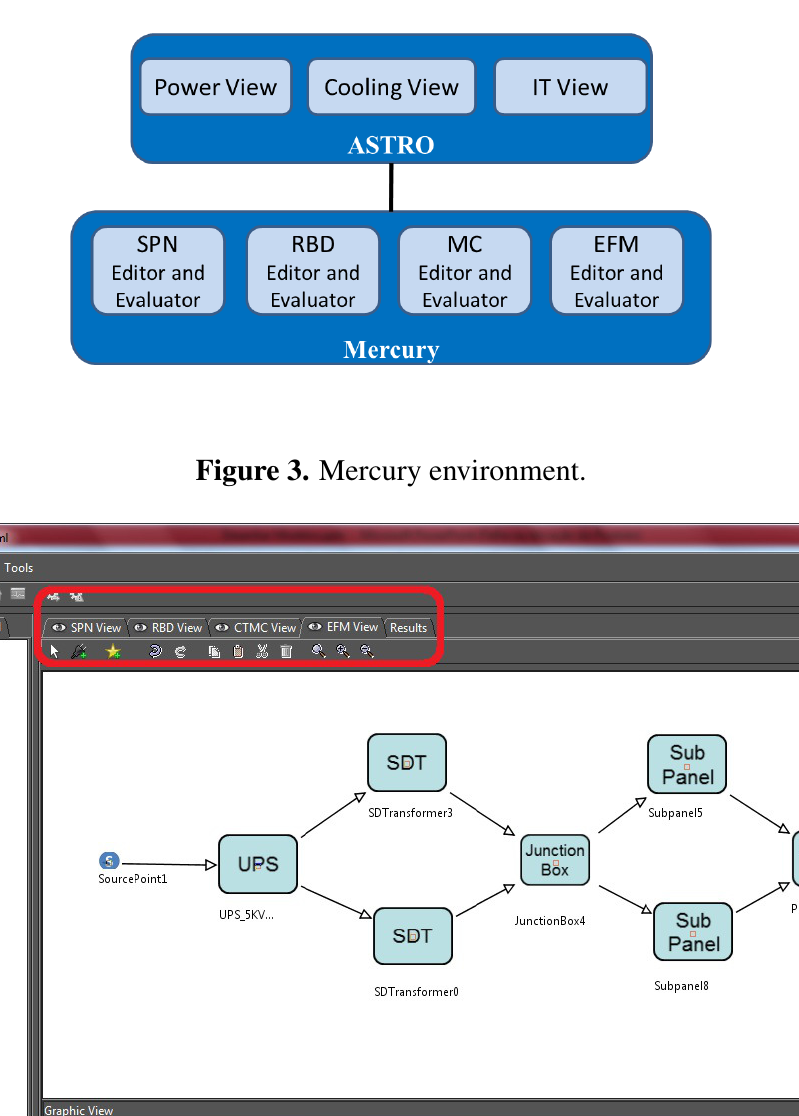
Figure 2. Environment functionalities.